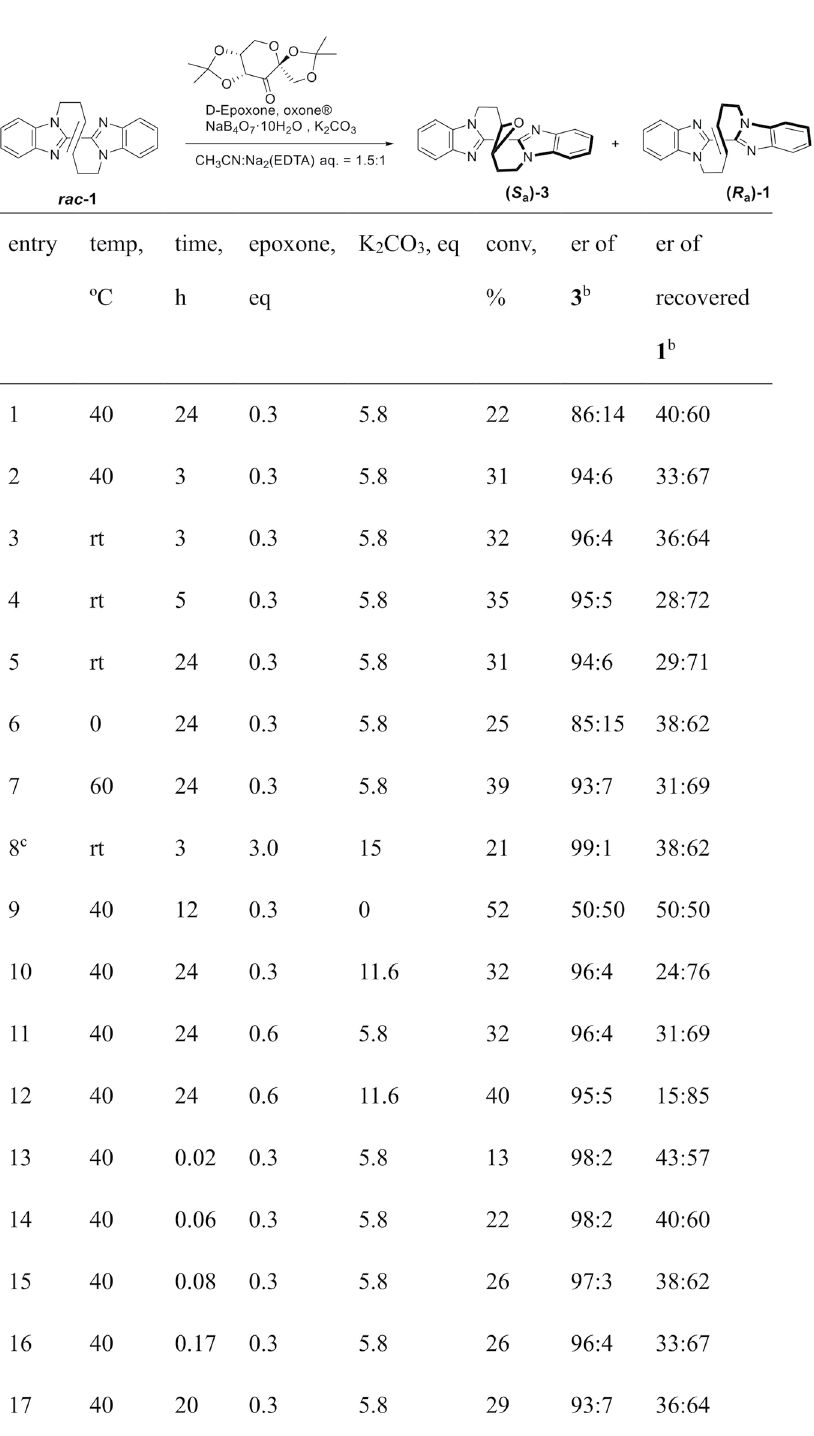
by decomposition of D-epoxone, would occur along with the prolonged reaction periods. In the early stage of the reaction, the enantiomeric ratio of the obtained epoxide 3 was much higher. (entry 13–17) Employing the results on the reaction period of < 5 min, the relative rate of the formation of 3 was estimated as k rel = 35.0. We then studied the use of chiral ketone in the kinetic resolution by asymmetric epoxidation. Figure 4 summa- rizes the employed ketones for the reaction. In addition to natural terpene ( − )-menthone ( 2b ) and ( + )-camphor